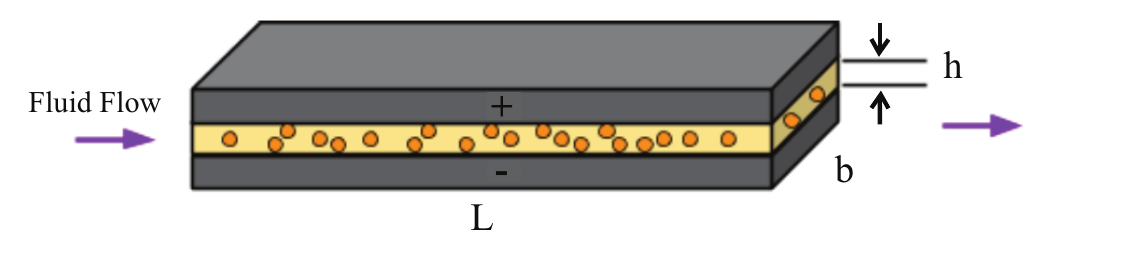
Figure 2. The schematic shows the geometrical parameters of an ERF